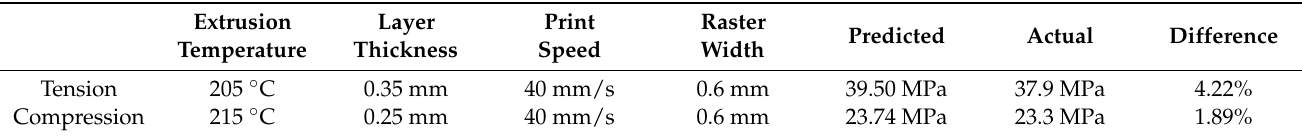
Table 5. Confirmation experiment for Taguchi